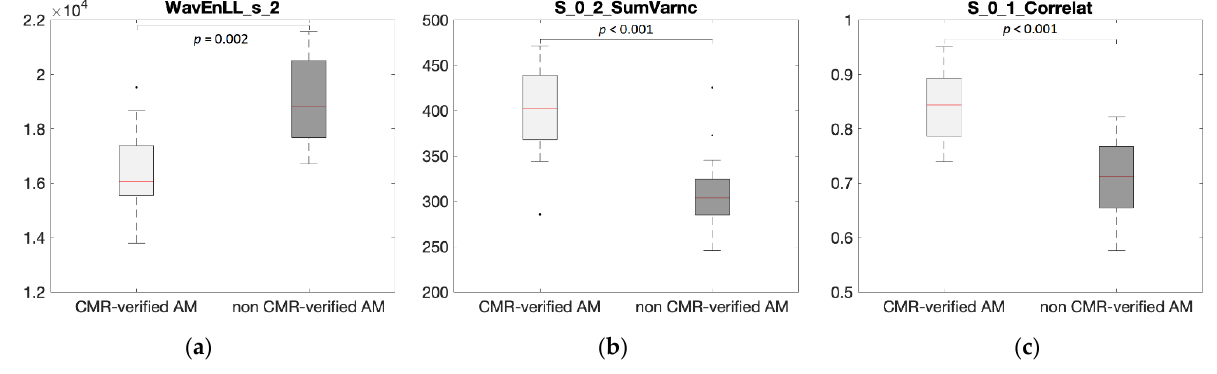
Figure 2. Box plots illustrating the large difference in myocardial tissue textures in ( a ) T2-weighted, ( b ) late gadolinium enhancement, and ( c ) CINE images between patients with CMR-verified AM and non CMR-verified AM. In specific, WavEnLL_s_2, S_0_2_SumVarnc, and S_0_1_Correlat that presented the highest correlation with AM (Table 3) are displayed. The median is presented by the centerline with the upper and lower limits of 25th and 75th percentiles, respectively. Texture fea- tures are dimensionless.